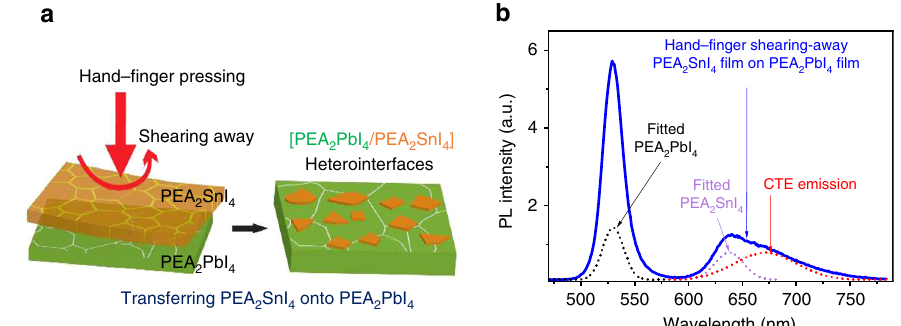
Fig. 3 Hand – fi nger pressing method to con fi rm CTE formation in 2D perovskite heterostructures. a Schematic diagram illustrates that PEA 2 SnI 4 fi lm is shearing away on PEA 2 PbI 4 fi lm surface to prepare double-layered [PEA 2 PbI 4 /PEA 2 SnI 4 ] heterointerfaces. b PL spectrum was measured for double-layered [PEA 2 PbI 4 /PEA 2 SnI 4 ] heterointerfaces. The broad emission is shown as an extended spectral tail in addition to intrinsic emission (530 and 637.5 nm) from PEA 2 PbI 4 and PEA 2 SnI 4 components. The dashed lines are shown for three spectral components from PEA 2 PbI 4 component, PEA 2 SnI 4 component, and [PEA 2 PbI 4 /PEA 2 SnI 4 ]